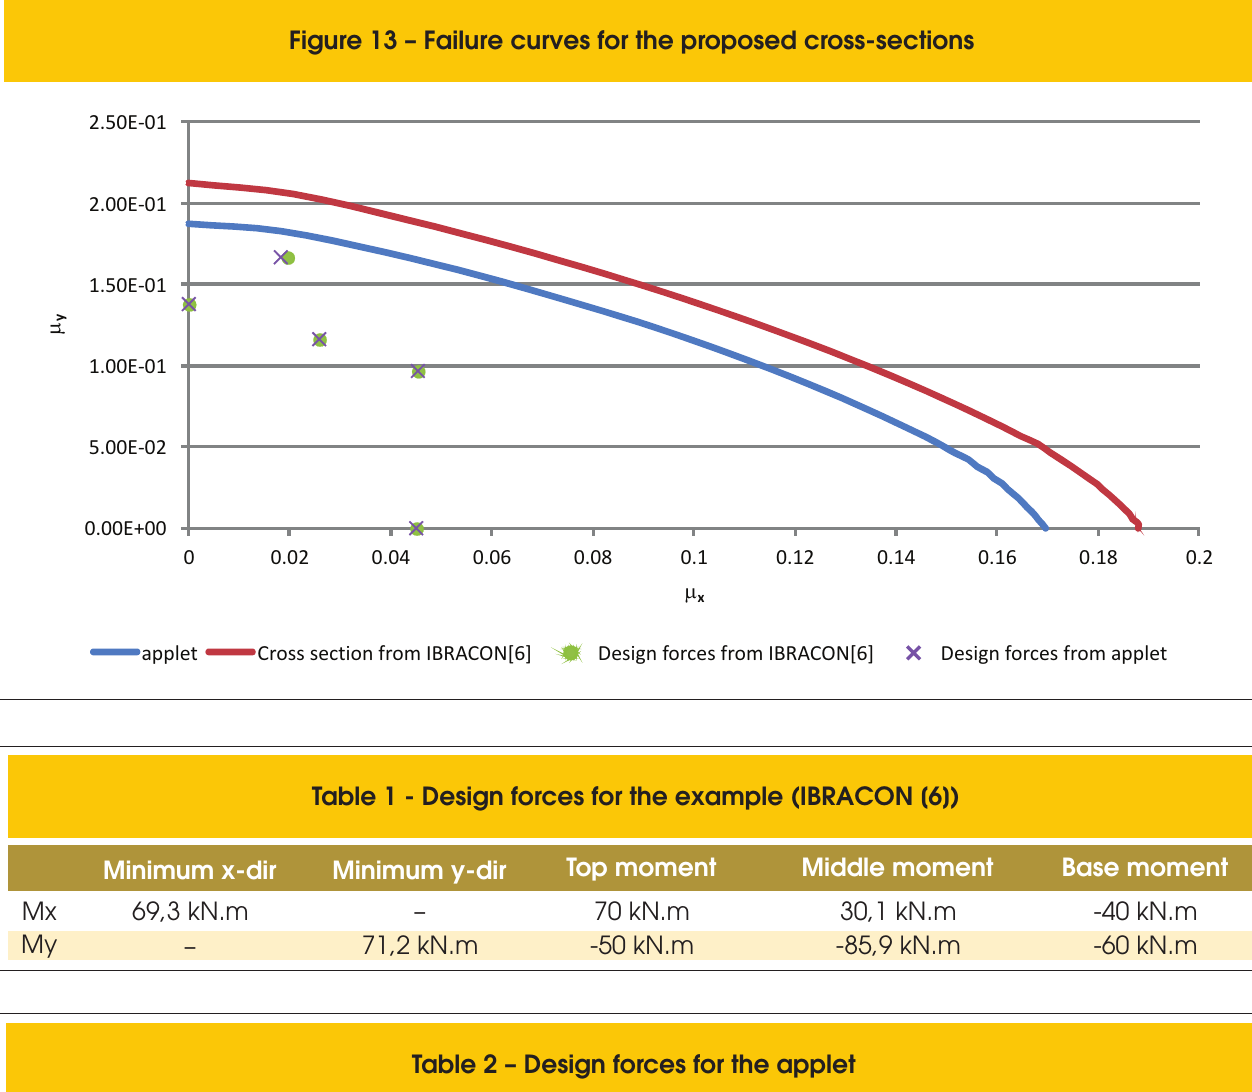
Figure 13 – Failure curves for the proposed cross-sections